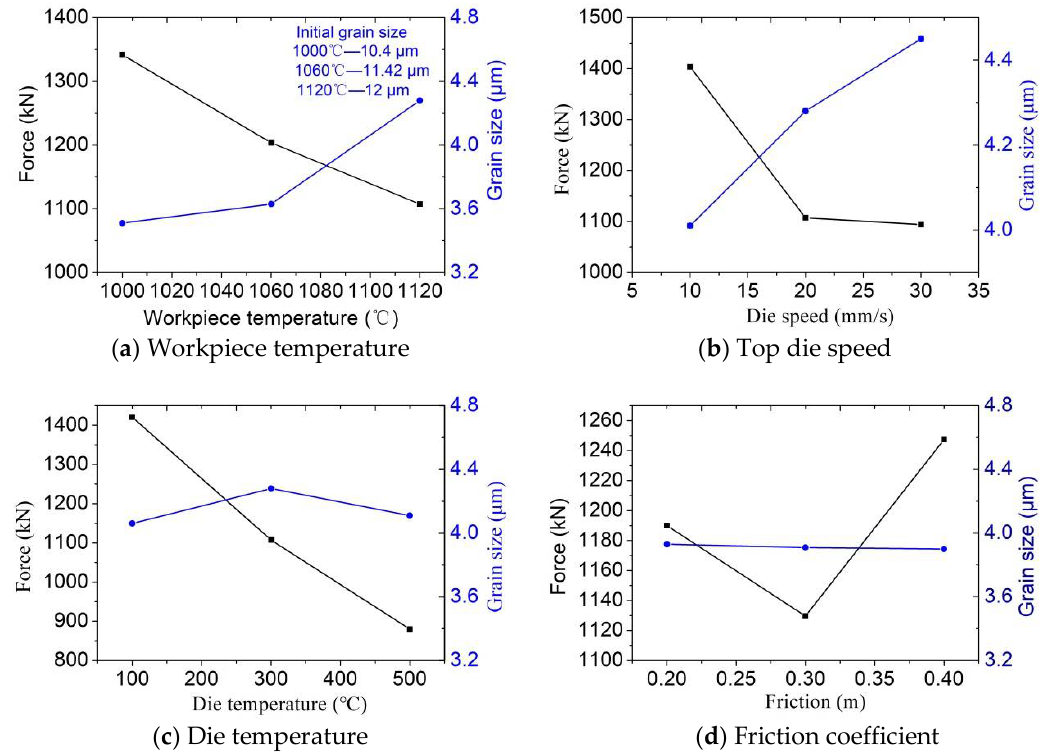
Figure 15. Effects of processing parameters on the forging process.